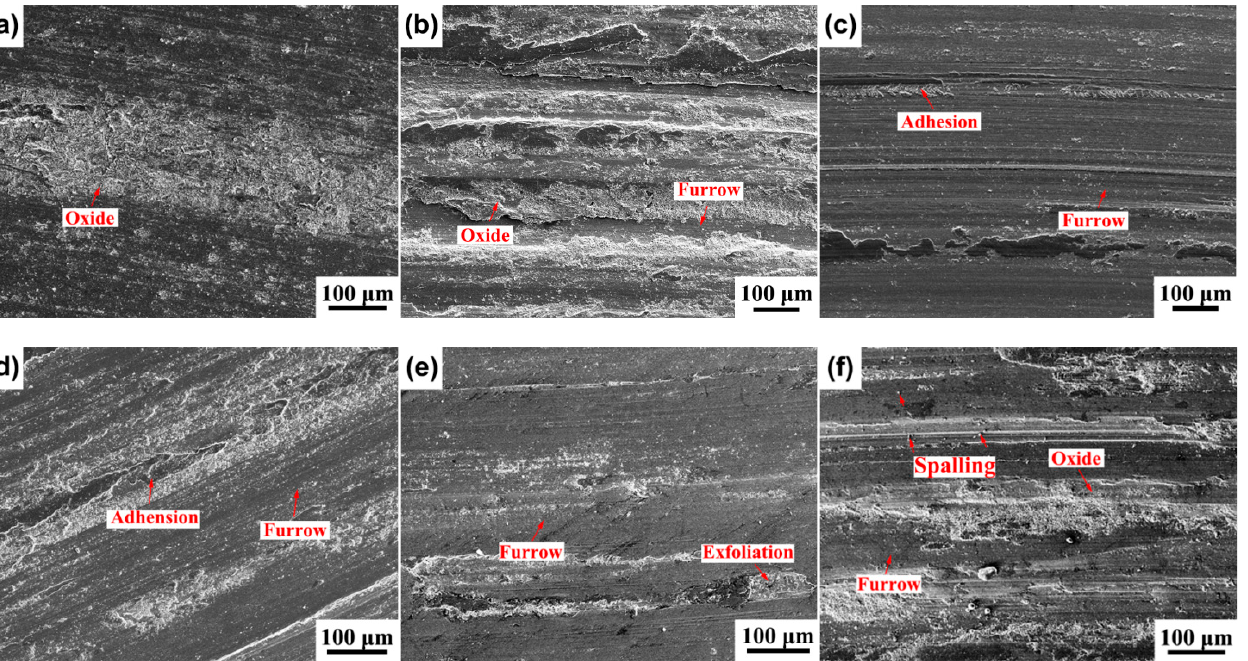
Figure 9. Worn surface morphology of different processes: ( a ) 0 M, ( b ) 5 M, ( c ) 10 M, ( d ) 15 M, ( e ) 20 M, ( f ) 25 M.